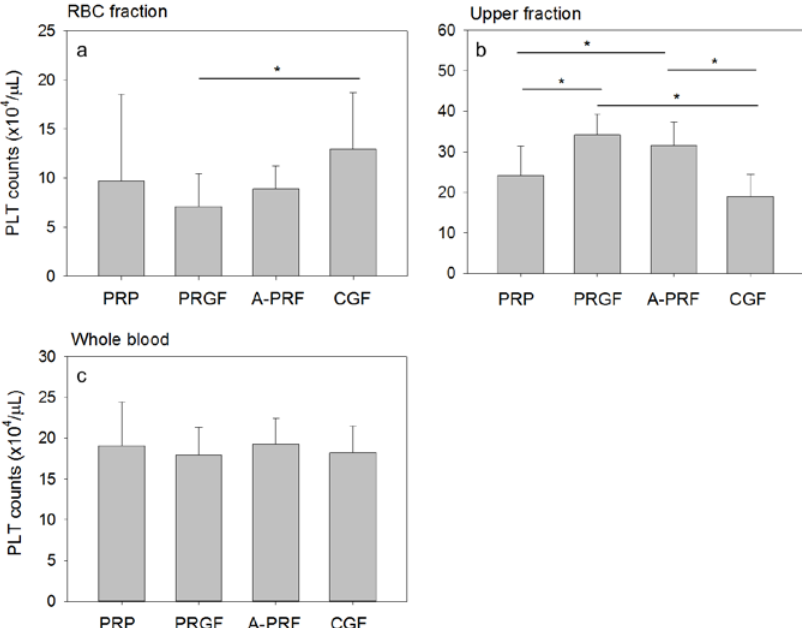
Figure 2. Platelet (PLT) counts in the RBC fraction ( a ), upper plasma fraction ( b ), and whole blood sample ( c ). Peripheral blood samples were collected in the presence of the anti-coagulant and centrifuged by the individual centrifugation protocols. The upper fraction was collected above the line indicated in Table 1. The rest of the fractionated sample was used as the RBC fraction. N = 12–15. The asterisks represent statistically significant difference ( p < 0.05).